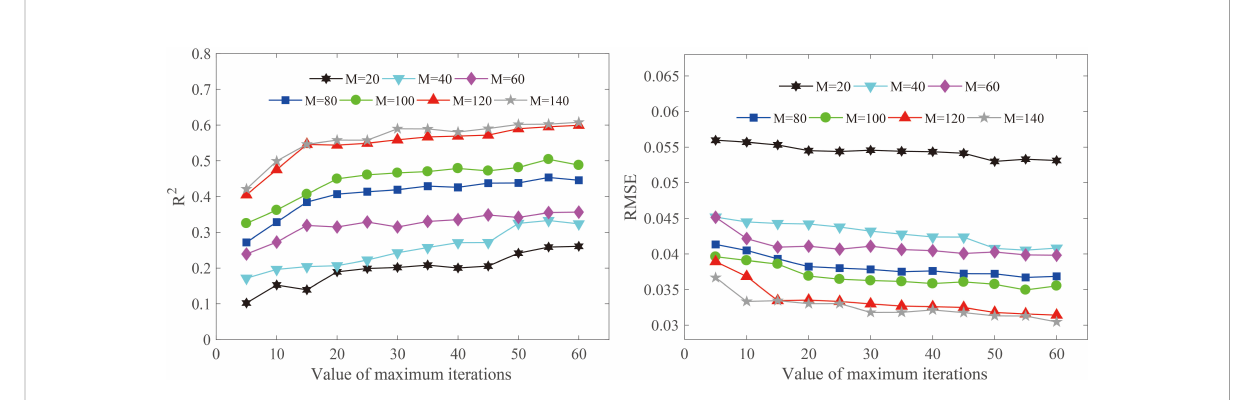
FIGURE 10 Effects of the value of maximum iterations on model